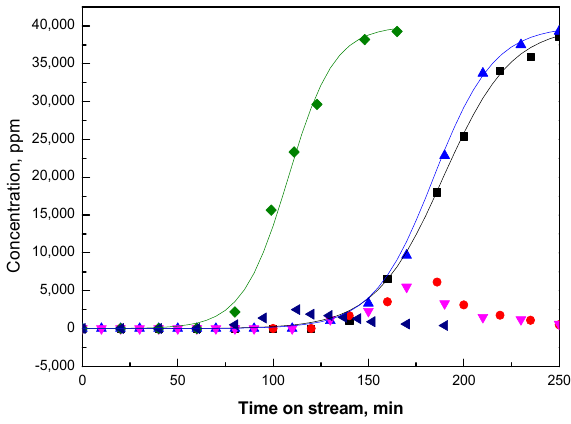
Figure 2. Ethanol breakthrough curve ( ■ ) and acetaldehyde formed in the test ( • ) for fresh Pt/NaY-SiO 2 ; ethanol breakthrough curve ( ▲ ) and acetaldehyde formed ( ▼ ) for PtR (HF) ; ethanol breakthrough curve ( ¨ ) and acetaldehyde formed ( ◄ ) for PtR (LF) .